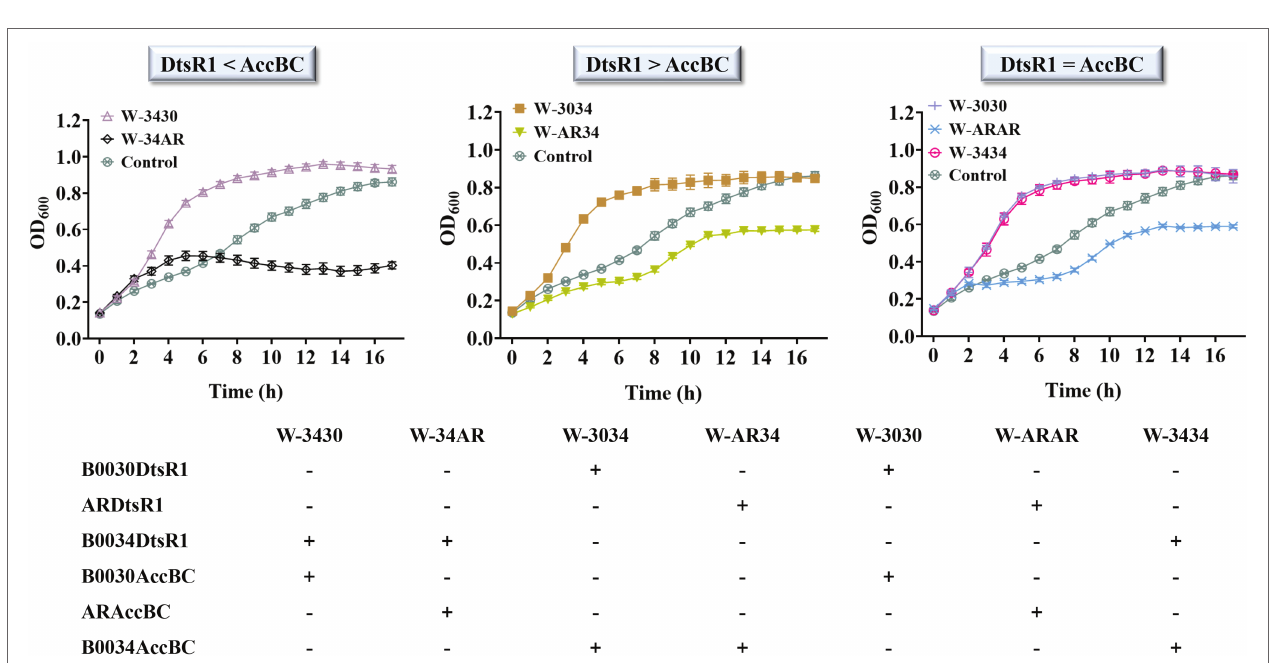
FIGURE 4 | Modified expression of DtsR1 and AccBC and their influence on cell growth in Escherichia coli BL21 (DE3). The adjusted DtsR1 and AccBC expression is listed as three levels according to RBS strength: DtsR1 < AccBC, DtsR1 > AccBC, and DtsR1 = AccBC. Strain containing empty vector without Acc expression was the control. The strength of RBS was calculated with the ratio of RFP/OD 600 : 65,116 (B0030), 46,388 (AR), and 36,515 (B0034). All results were calculated with three ( n = 3) independent replicates.